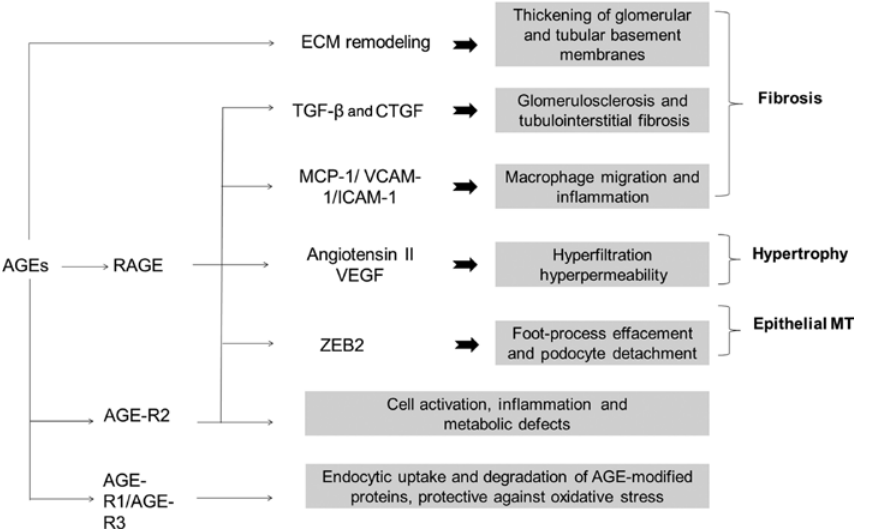
Figure 3: AGE modification of ECM proteins results in remodeling and thickening of the basement membrane. Stimulation of RAGE by AGEs in addition to increased production of reactive oxygen species resultesin the activation of various signaling